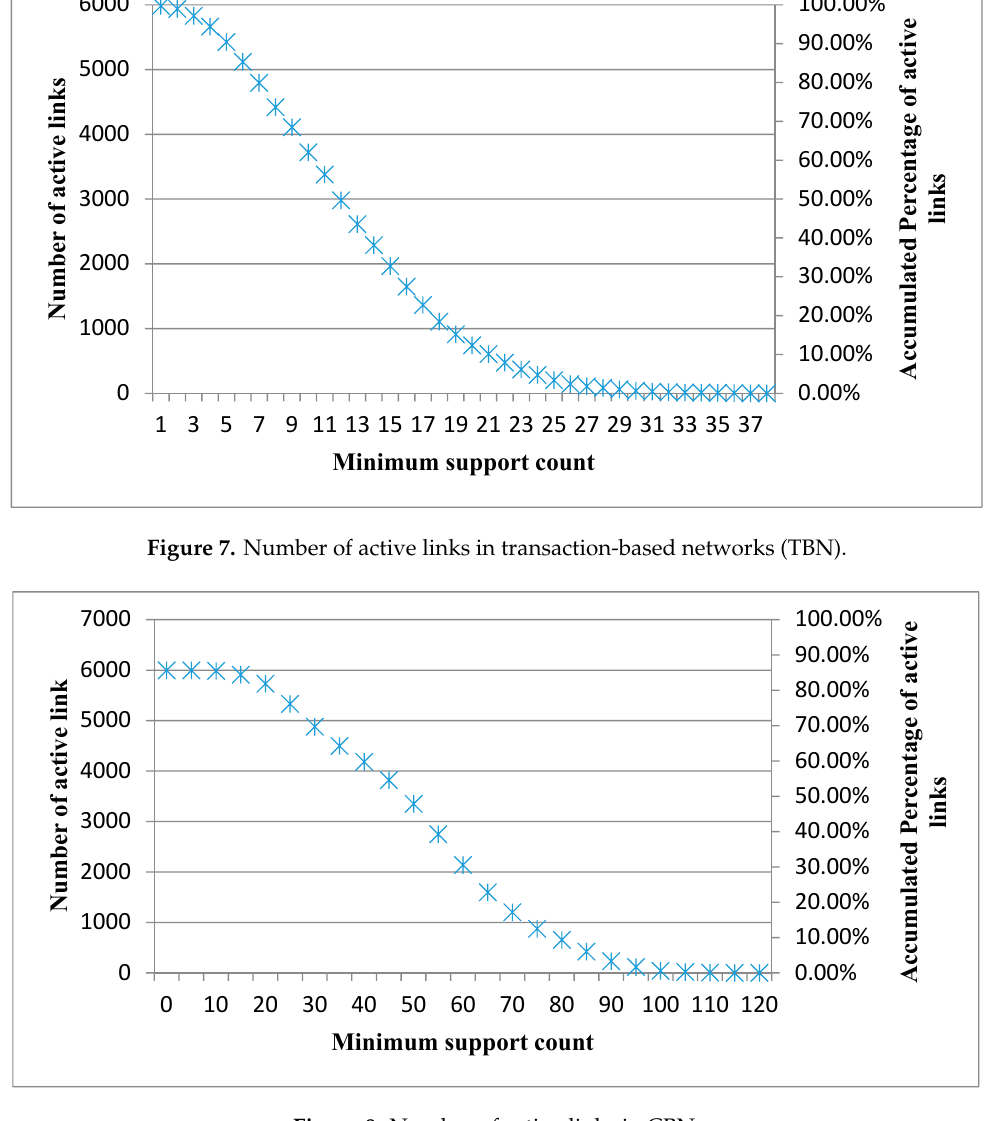
Figure 8. Number of active links in